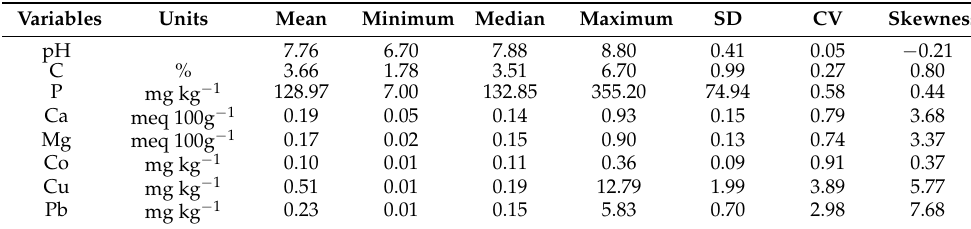
Table 1. Descriptive statistics of studied variables (n = 67).